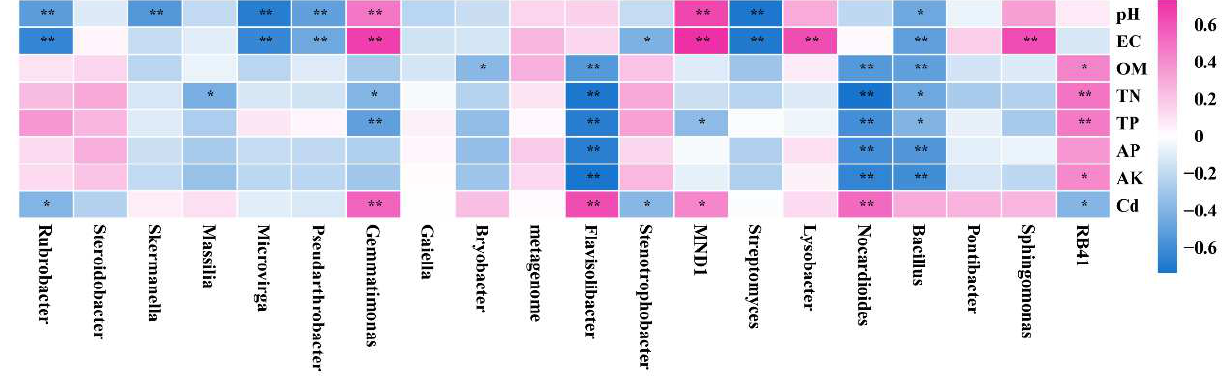
Figure 5. Spearman rank correlation Heatmap used to study the environmental factors and bacterial community compositions. * means 0. 01 < p ≤ 0. 05, ** means p ≤ 0.001